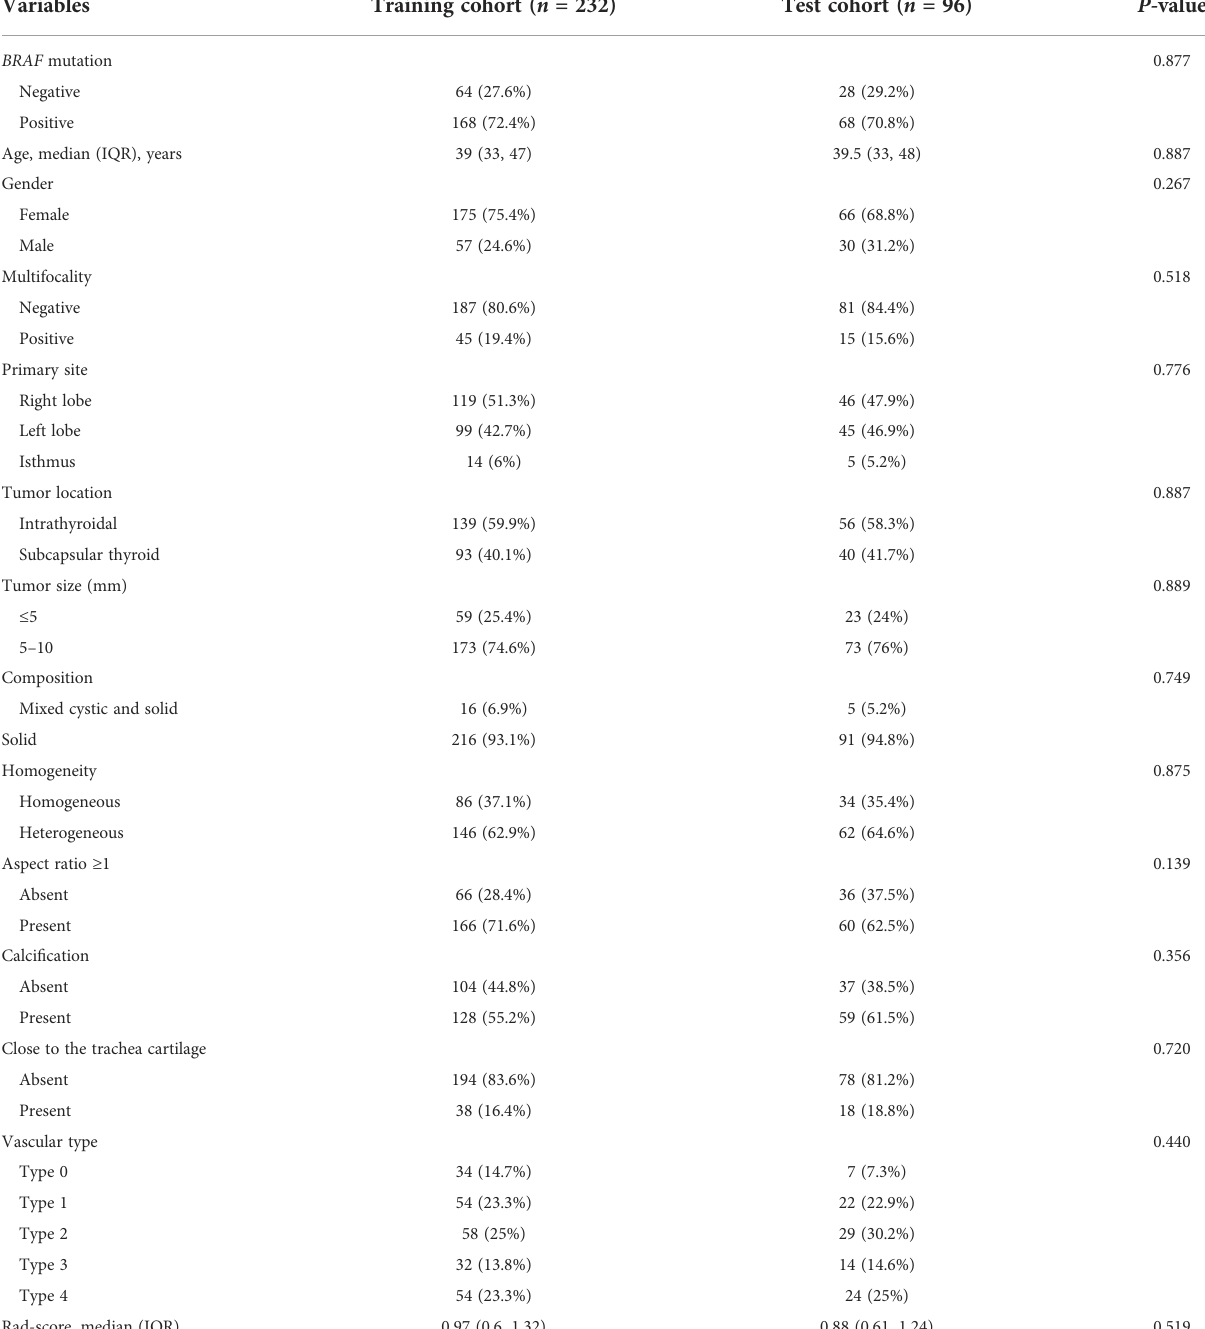
TABLE 1 Clinical and US characteristics of PTMC patients in the training and validation